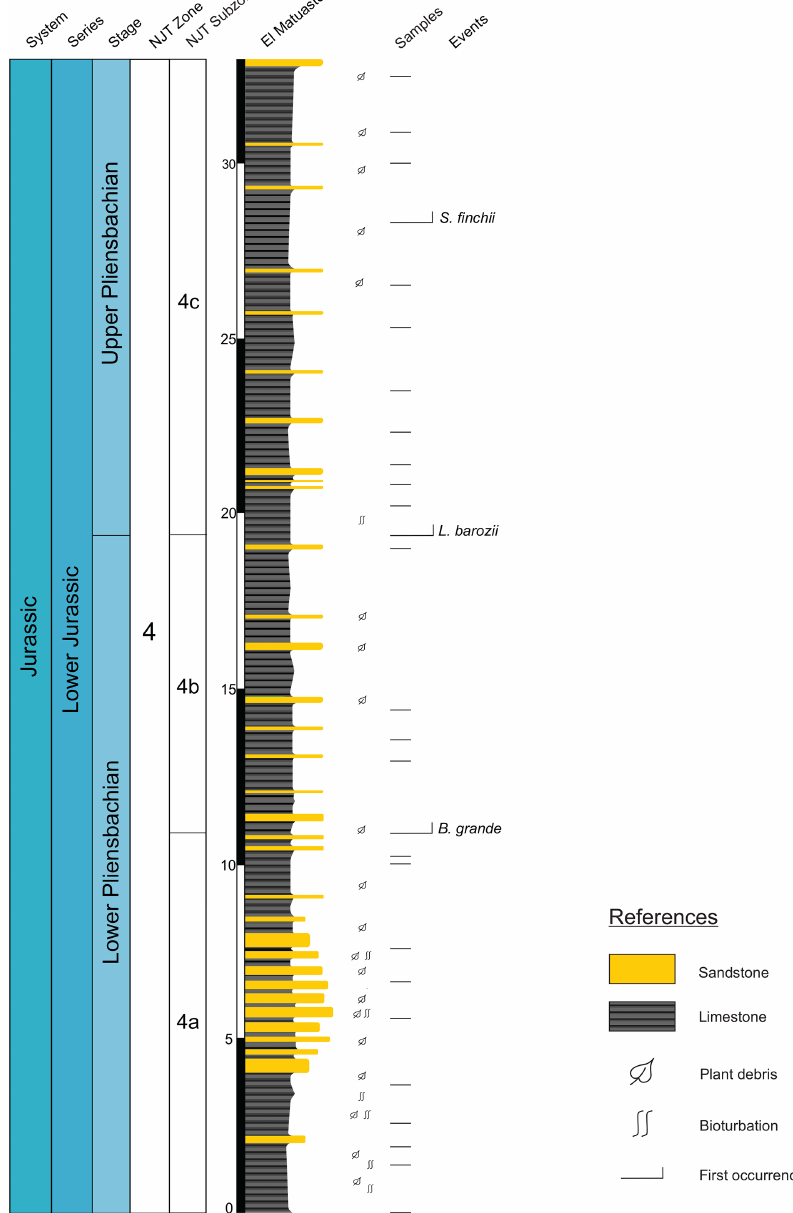
Figure 4. Integration of El Matuasto I sedimentary section with the chronostratigraphy, the nannofossil Tethyan zones (NJT; Ferreira et al., 2019), and the main